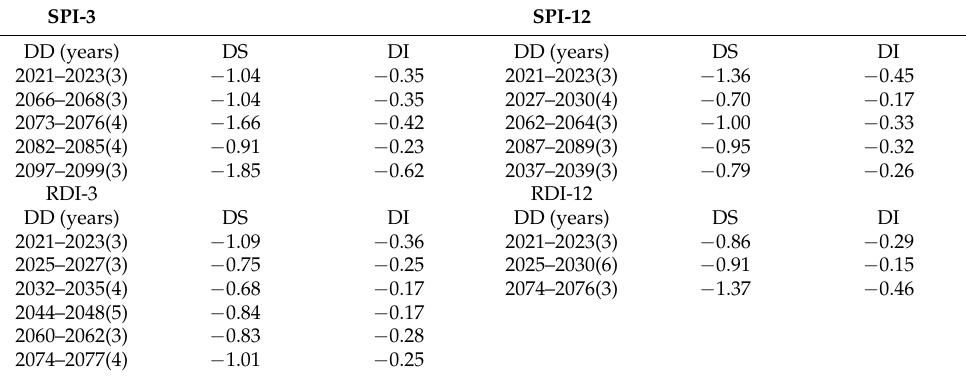
Table 4. Drought duration (DD), drought severity (DS), and drought intensity (DI) under RCP 2.6. SPI-3